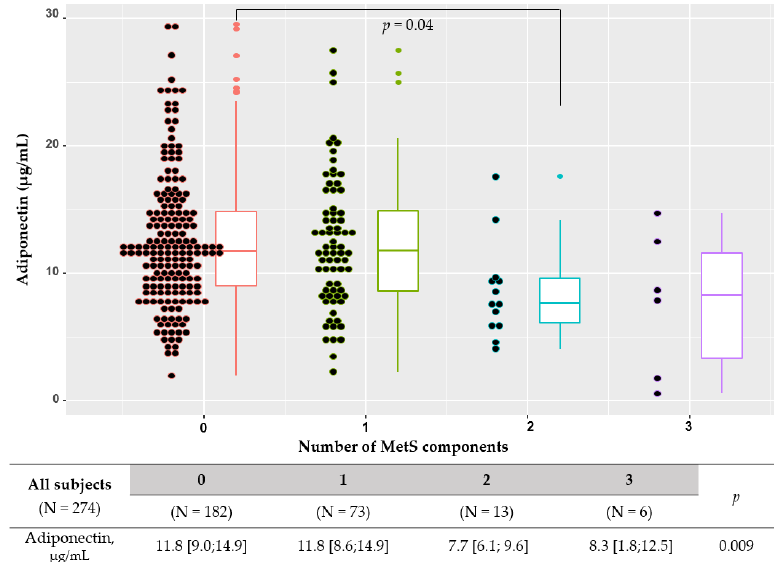
Figure 1. Box-and-whisker dot plots. Four group comparisons of serum adiponectin levels according to the number of metabolic syndrome (MetS) components. Kruskal–Wallis test with Turkey’s post hoc test was used: (0 vs. 1) p = 0.99, (0 vs. 2) p = 0.04, (0 vs. 3) p = 0.11, (1 vs. 2) p = 0.075, (1 vs. 3) p = 0.15, and (2 vs. 3) p = 0.99.